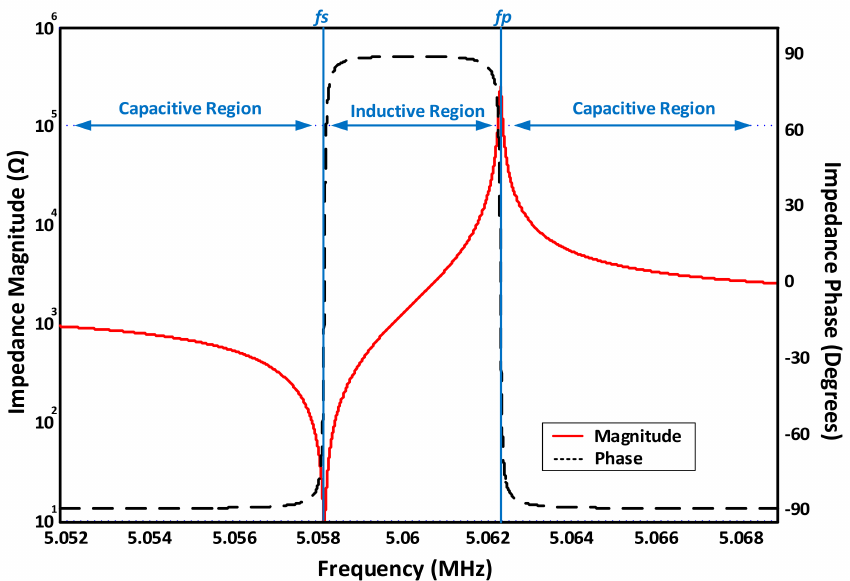
Figure 3. Impedance amplitude and phase plots around resonance frequency for a typical high quality, lightly loaded, 5 MHz